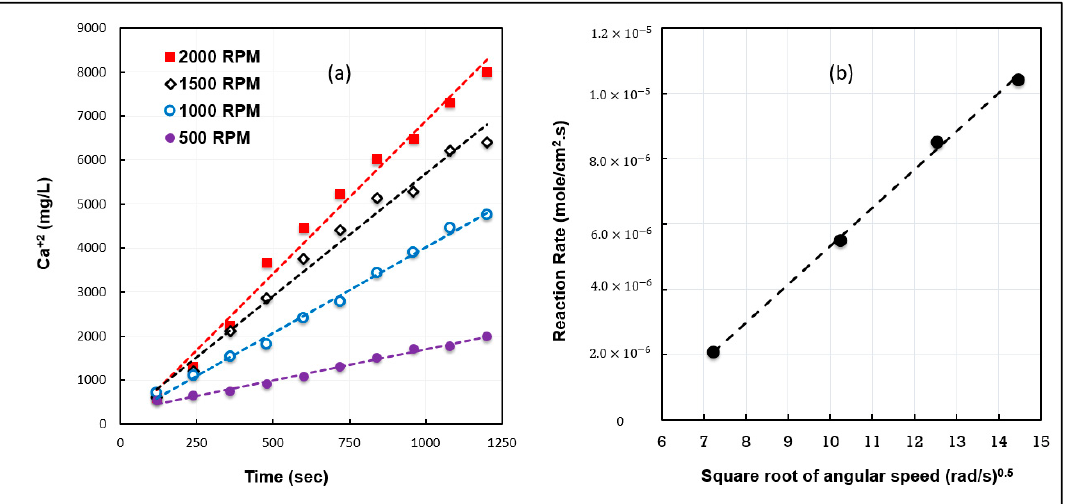
Figure 10. ( a ) The concentration of calcium in the collected fluid samples as a function of time and rotation speed using 20 wt% GLDA/SW solution with Austin chalk disks at 200 °F; ( b ) the Rate of calcite dissolution in 20 wt% GLDA/seawater at pH of 3.8 at 1000 psi and 200 °F.